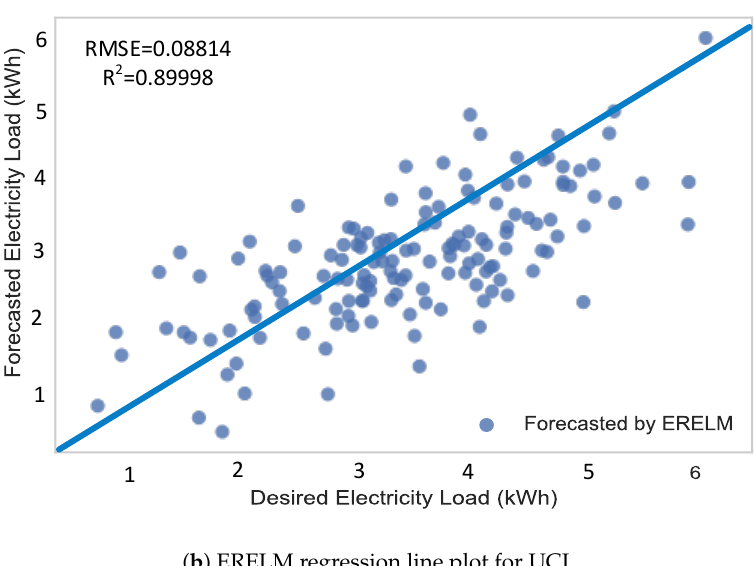
Figure 14. Regression line plots using